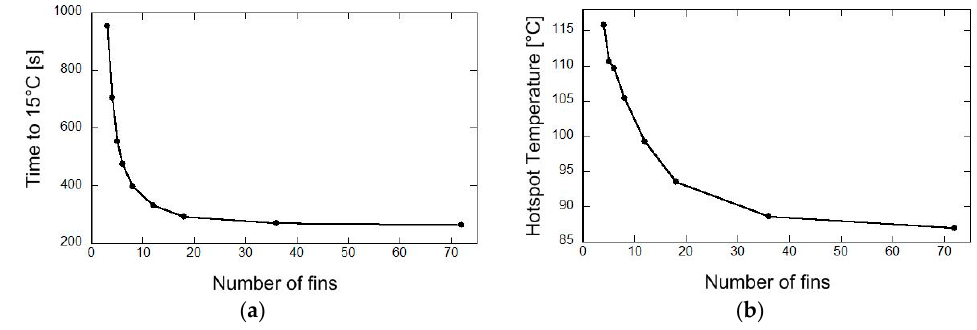
Figure 6. The effect of the number of fins on the heat transfer. ( a ) Time required to cool to 15 °C; ( b ) Hot spot temperature.